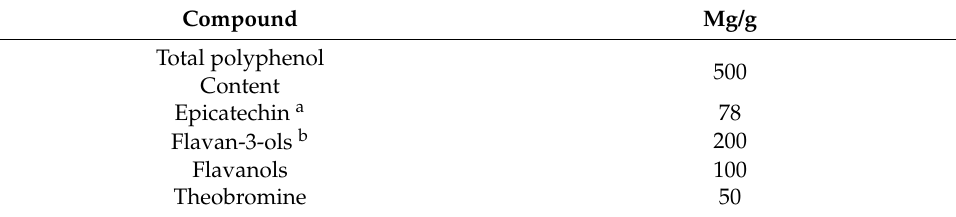
Table 1. Composition of the high polyphenol-containing cocoa product.